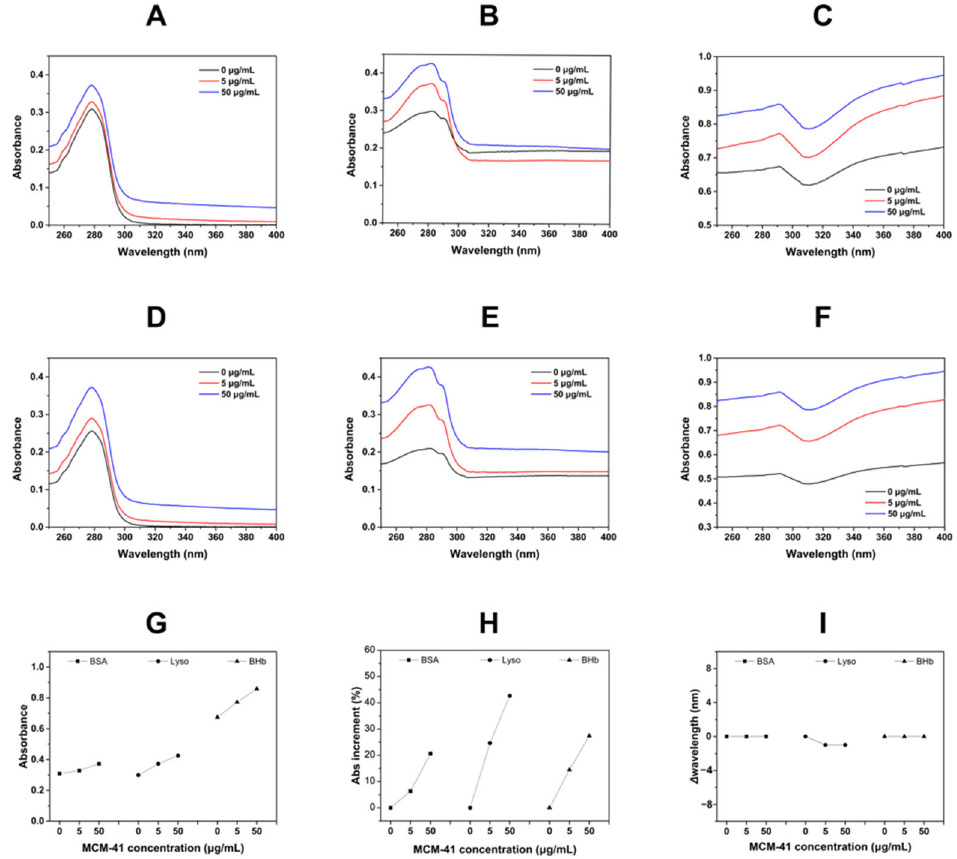
Figure 2. ( A – C ) UV-Vis spectra of MCM-41 incubated with BSA ( A ), Lyso ( B ) and BHb ( C ). ( D – F ) The normalized UV spectra: BSA ( D ), Lyso ( E ) and BHb ( F ). ( G ) The Abs increment of MCM-41 was incubated with different proteins. ( H ) The percentage of Abs intensity increment of different proteins incubated with MCM-41. ( I ) The ∆ wavelength of different proteins incubated with MCM-41. Then, the changes in emission wavelength ( ∆ emission) were summarized in Figure